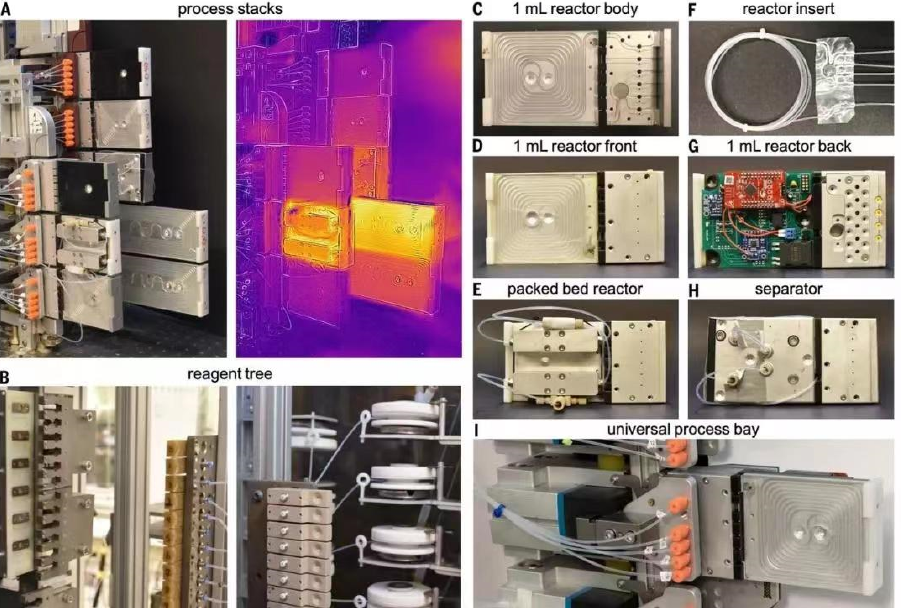
Figure 14. Component modules of the flow chemistry robotics platform: ( A ) process stack where modules are connected to the UPB to form a continuous flow path ( left ) and thermal image showing the heated reactor ( right ); ( B ) front view of the reagent tree and reagent manifold; ( C ) front view of the reactor body; ( D ) 1.0 mL reactor processing module; ( E ) double column packed bed reactor process module; ( F ) disposable PFA reactor insert; ( G ) integrated electronics on the back of the 1.0 mL reactor; ( H ) in-line membrane separator; ( I ) close-up of the UPB containing the 1.0 mL reactor. Reprinted with permission from ref. [60]. Copyright 2022, The American Association for the Advancement of Science.